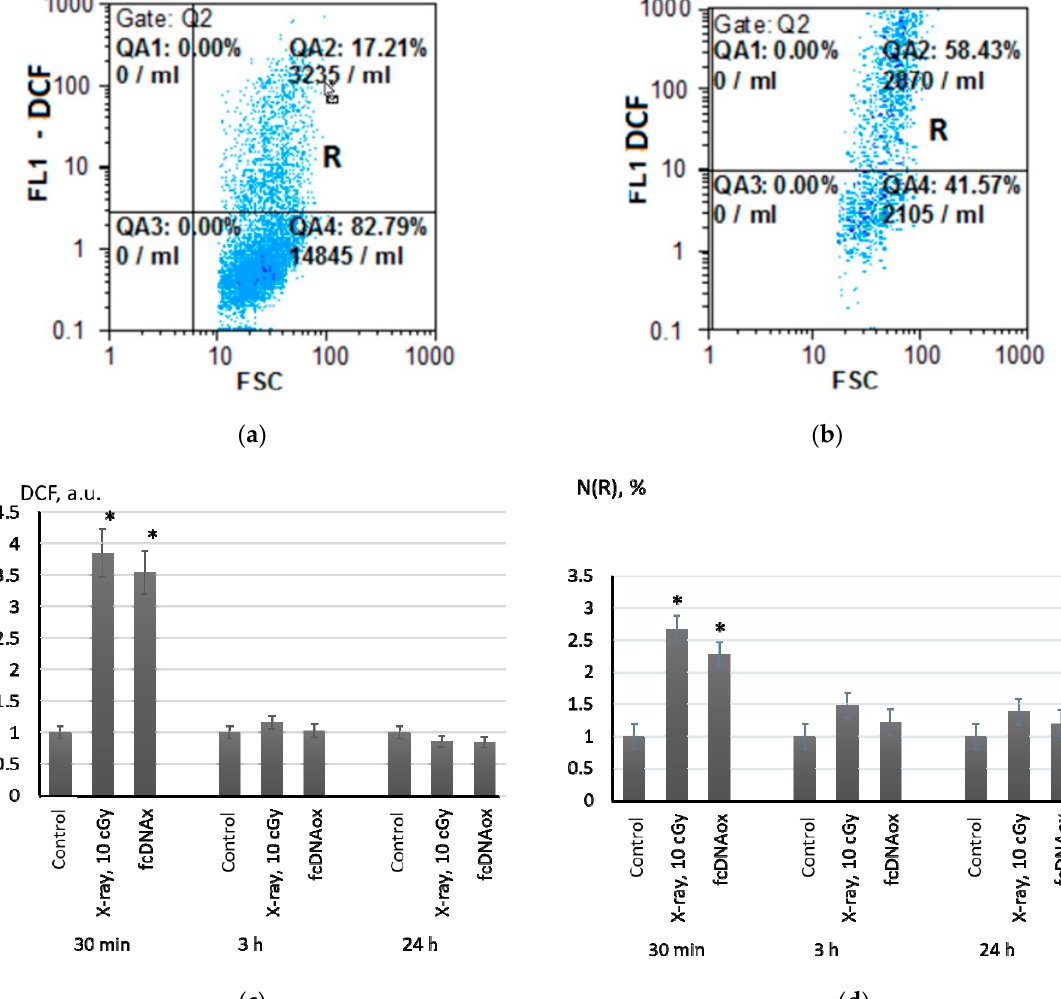
Figure 1. Intracellular ROS after X-ray radiation (10 cGy) and addition of the standard solution of cfDNAox (50 ng/mL) assessed by flow cytometry with a H2DCFH-DA dye; ( a ) FL1-DCF versus SSC for the control experiment; ( b ) FL1-DCF versus SSC for irradiated cells after 30 min; ( c ) histograms of DCF fluorescence measured by FACS; ( d ) histograms of R-fraction fluorescence in the MSCs. The histograms were built from three independent measurements on four cell cultures; mean values and standard deviations are given; (*) denotes a significant difference from control experiments, p < 0.001, nonparametric